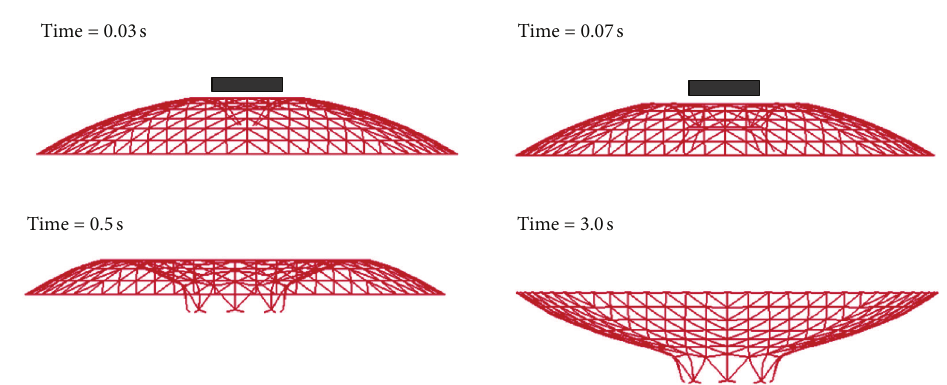
Figure 7: Damage process of the impact event with impactor of 10m diameter and 10T mass and the striking velocity of 100m/s.